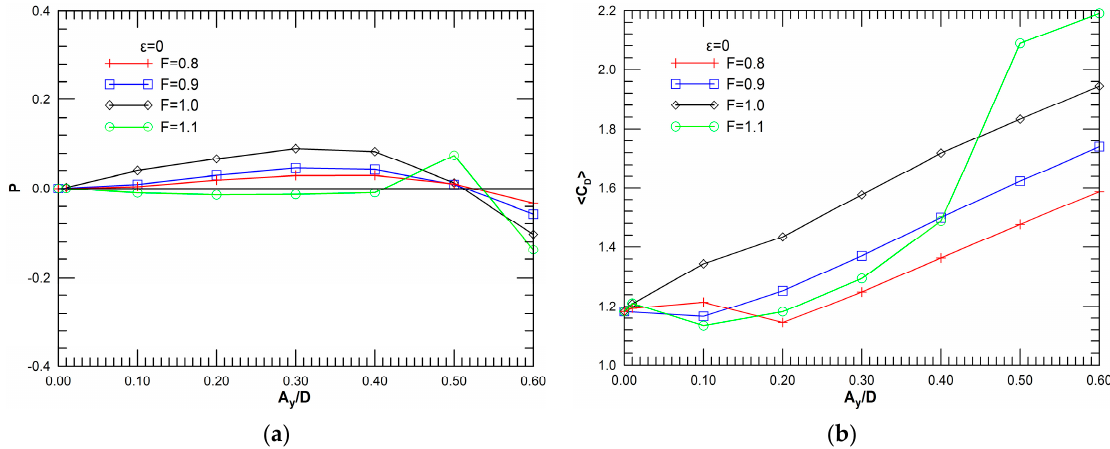
Figure 2. Variation of ( a ) power transfer parameter, P, and ( b ) mean drag coefficient, <C D >, versus the non-dimensional amplitude, A y /D, for transverse-only oscillation, for frequency ratio F = 0.8, 0.9, 1.0 and 1.1.